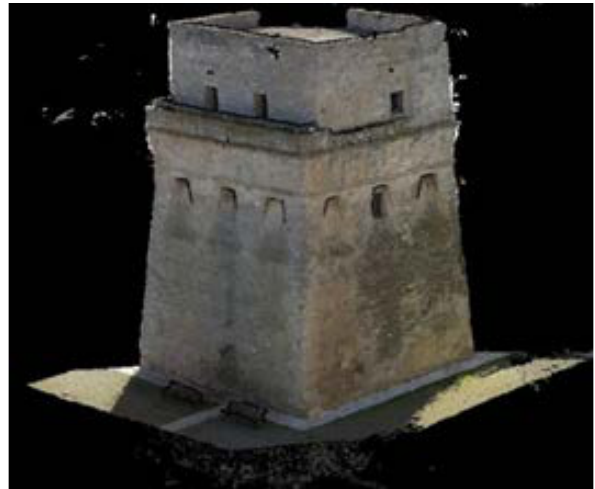
Figure 8: Shot from drone – effect of bright daylight